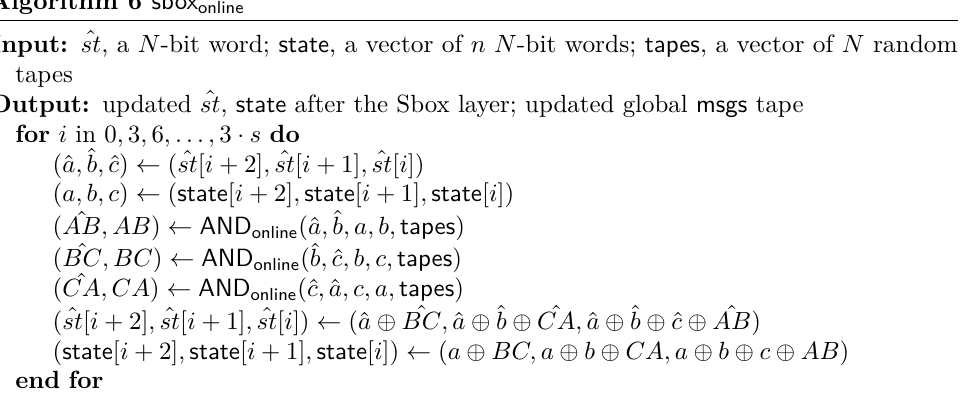
Algorithm 6 sbox online